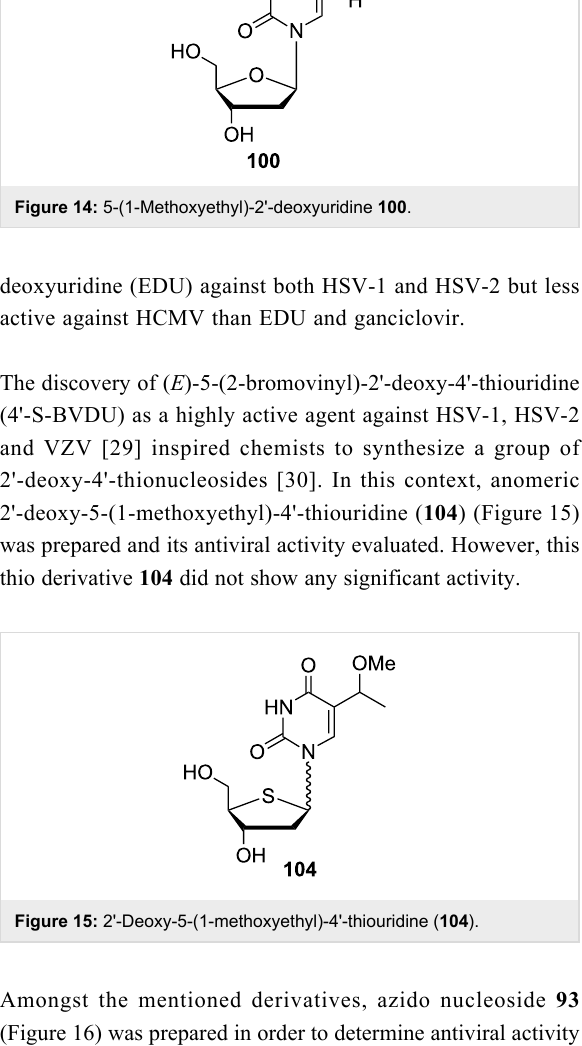
Amongst the mentioned derivatives, azido nucleoside 93